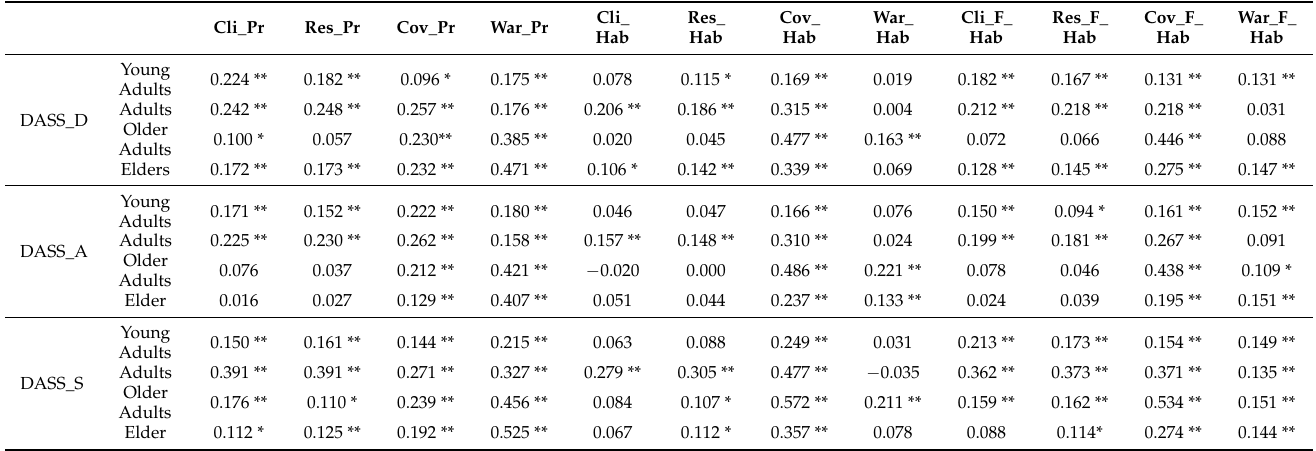
Table 3. Correlation coefficients (Pearson’s r) between the DASS-21 and preoccupation and habits change